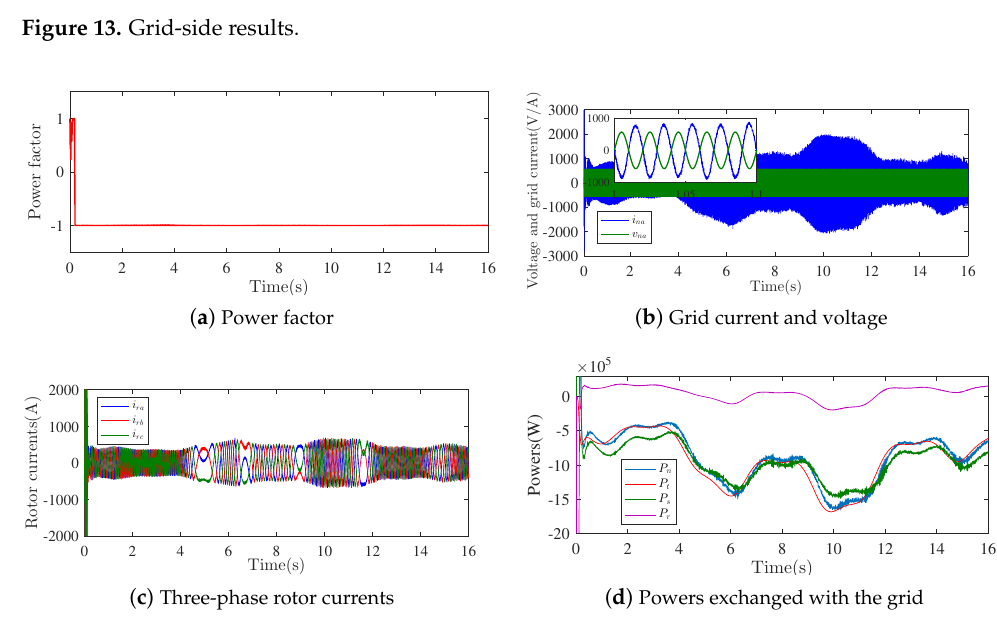
Figure 14. WECS powers.